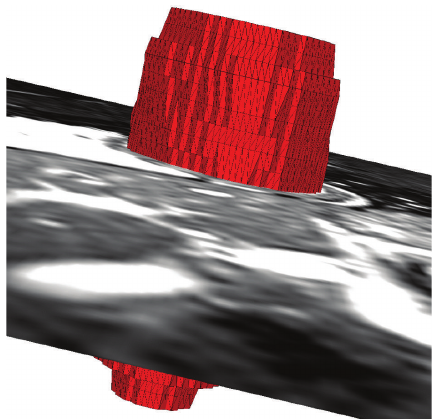
Figure 1: A left ventricular surface model generated by applying the marching cubes algorithm to a segmented cardiac MR image with 1.44 mm in-plane resolution and 8.0 mm slice thickness. The irregular triangles are a consequence of the voxel anisotropy. The surface mesh has pronounced terracing artifacts, and the number of triangles is directly related to the number of voxels in the